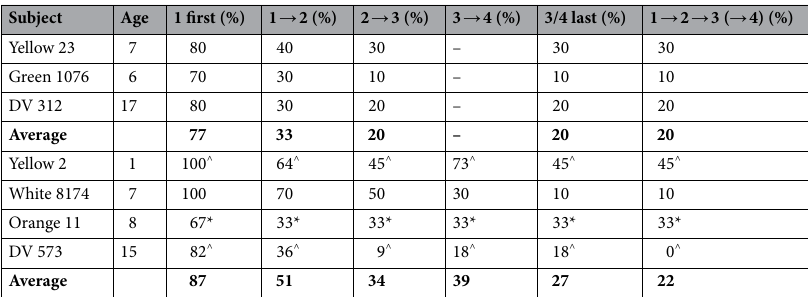
Table 4. Percentage of Memory Test trials (out of ten trials) during which a subject chose sequence item 1 before any other items (“1 first”), chose sequence item 2 directly after item 1 (“1 → 2”), chose sequence item 3 directly after item 2 (“2 → 3”), chose sequence item 4 directly after item 3 (“3 → 4”; only for those pigeons that had experienced training stage 4), chose the final trained items as its last choice (“3/4 last”), and when a subject completed the entire sequence of either three or four trained items in its correct order (“1 → 2 → 3 ( → 4)”). Individuals are listed in order of the number of items they were trained on; those that only completed up to TS3 were not expected to visit sequence item 4. *Based on three trials. ^ Based on 11 trials.